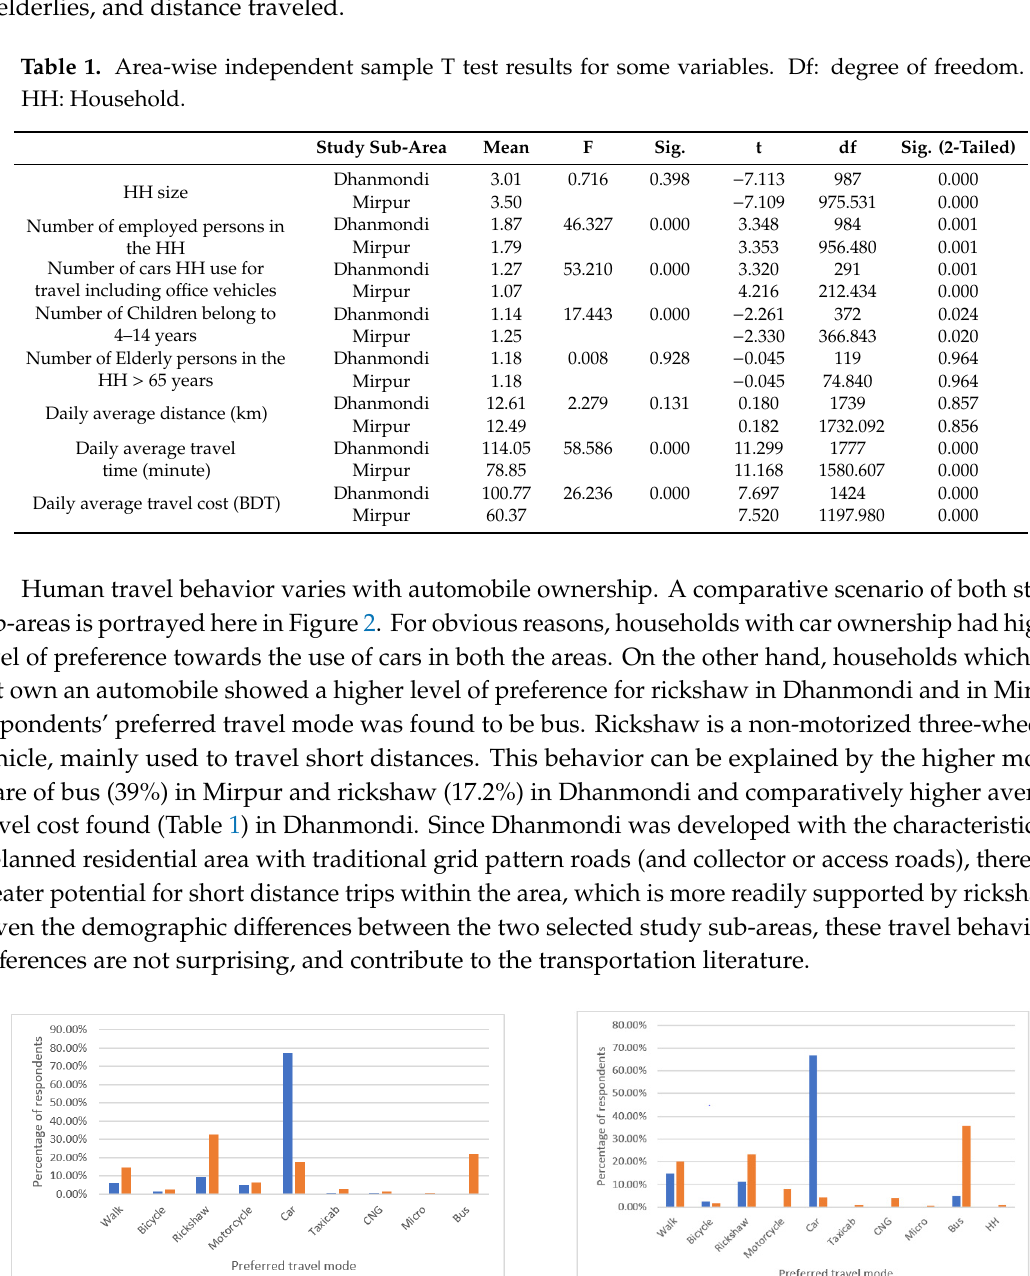
Table 2. Descriptive statistics of household activity length using shortest path network (SPN) method and HH activity space/area using road network buffer (RNB) method.